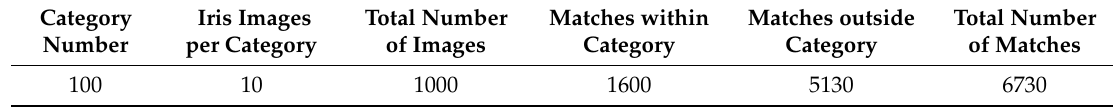
Table 1. Number of comparisons of image processing layer